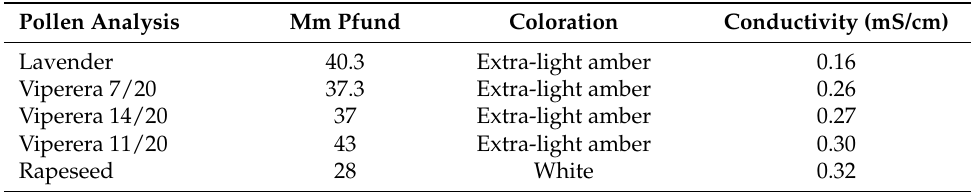
Table 10. Relationship of conductivity and coloration of the samples provided by the Association of Beekeepers of the Community of Madrid